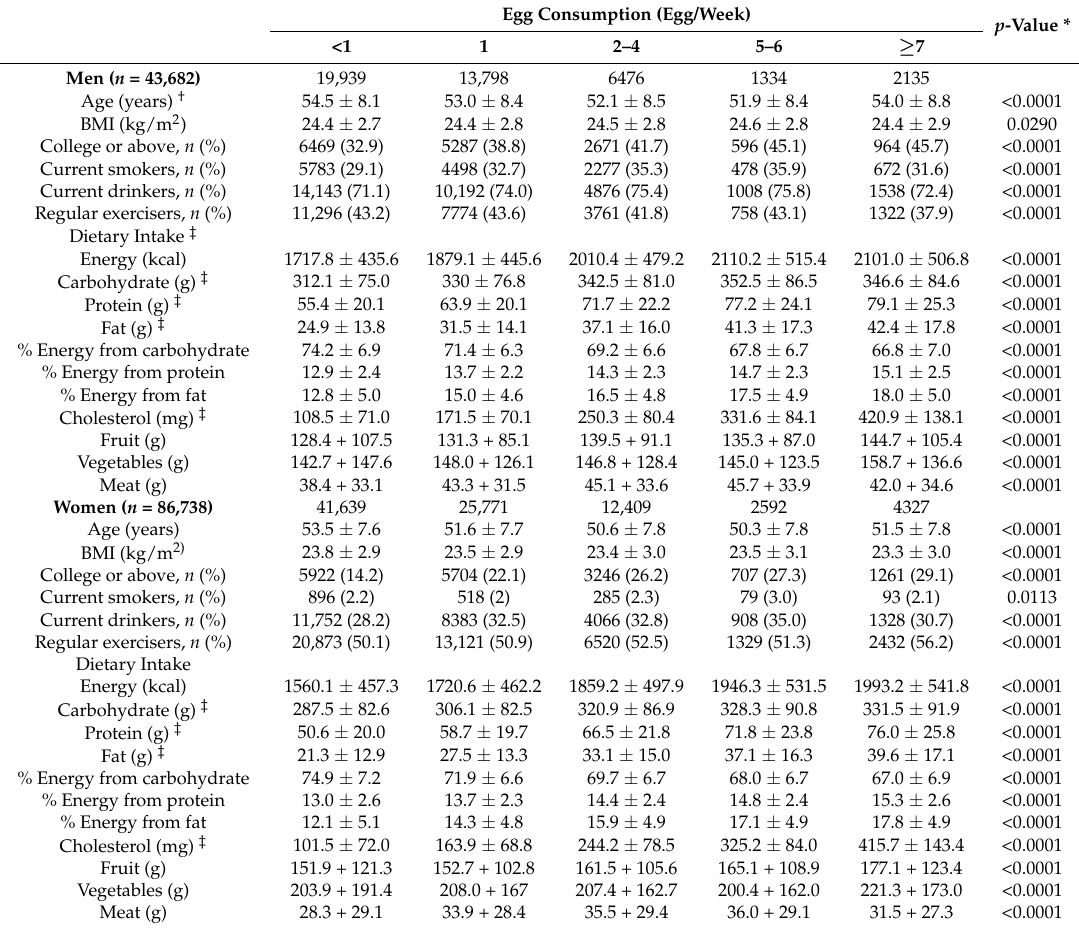
Table 1. Baseline characteristics by egg consumption, the Health Examinees Study-Gem (HEXA-G) study,